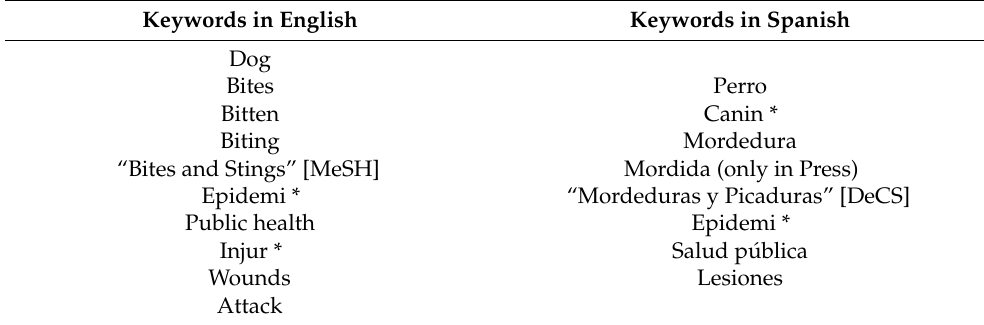
Table 1. Keywords in English and Spanish. Multiple keywords were used in the collection of articles (Table 1). Each word was searched in both English and Spanish, with only a few exceptions in one language (e.g., canin *) in response to the first search strategy test, as it sometimes only has responses in one language.